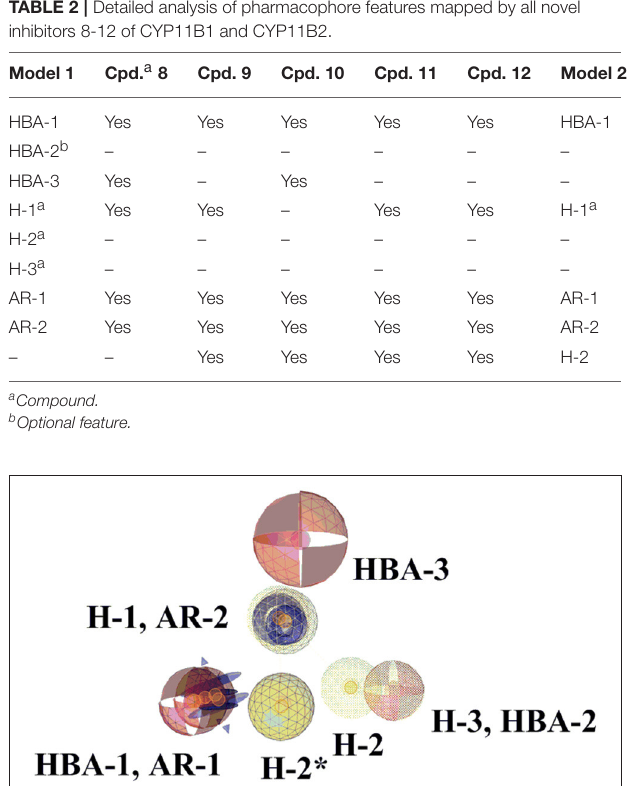
FIGURE 8 | Comparison of pharmacophore models 1 and 2. The highlighted features (wireframe) are from pharmacophore model 2. The pharmacophore features are color-coded. Yellow represents hydrophobic, blue denotes AR, and red shows the HBAs. Four pharmacophore features of both pharmacophores are common. H-2* is hydrophobic feature from model